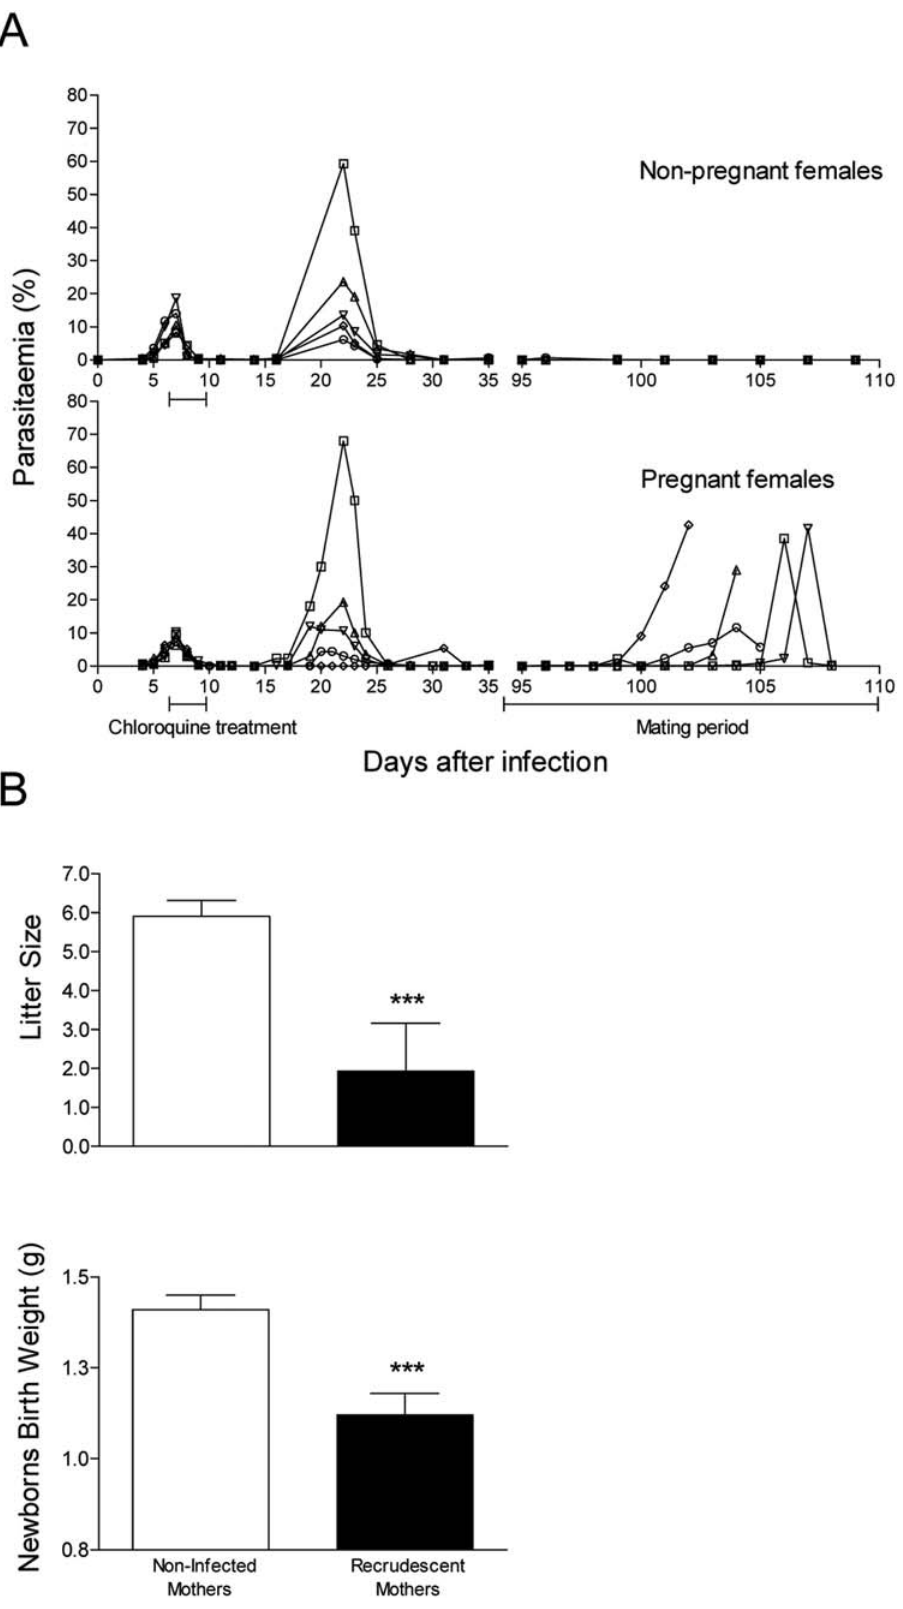
Figure 1. Malaria susceptibility is increased during pregnancywith detrimental effects for the progeny. Representative parasitemia curves of BALB/c females infected with P. berghei - GFP (day 0) and treated with chloroquine for 3 days starting at day 7 (Panel A). Parasitemias of females maintained without male (non-pregnants) are represented in the upper plot. The lower plot shows 5 typical parasitemia curves of recrudescent primigravida. In Panel B average litter size and birth weight of 20 litters from non-infected primiparous females are compared with the average litter size of 29 litters and the birth weight average of 6 litters, from recrudescent primiparous females. Error bars represent standard error (***, p , 0.001). doi:10.1371/journal.pone.0005630.g001 PLoS ONE |